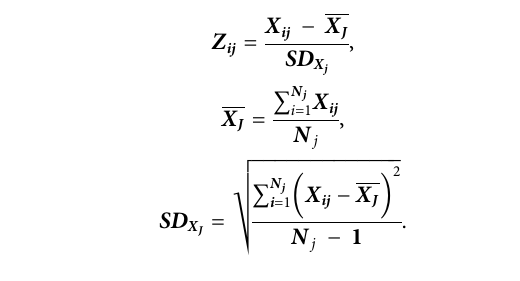
Frontiers in Pharmacology |